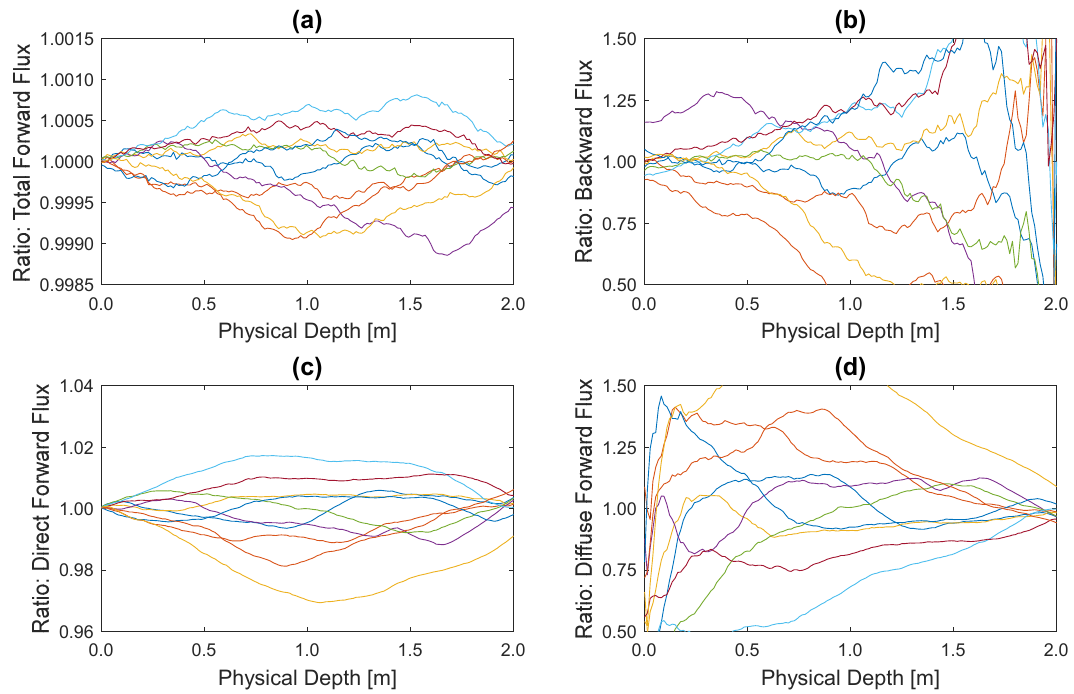
Figure 9. Point-by-point ratios calculated between flux results from LES-positioned droplet locations and those where uniformly random particle locations are used, shown as a function of physical depth. Values of 1 indicate a perfect match at a given physical depth, suggesting negligible impact from spatial correlation. Values above and below 1 suggest increases and decreases (respectively) from the homogeneous case due to spatial correlation. Note that the impact of spatial correlation is much larger in the center of the chamber, while the ratio curves tend to converge at the propagation endpoints (since the effective optical thickness values are very similar). As in several previous figures, panels ( a )-( d ) show total forward, backward, direct forward and diffuse forward fluxes (respectively). Examining these ratio results at the most convenient sensor locations (a depth of 2 m for all forward flux components, and a depth of 0 m for backward flux) allows us to estimate both the steady